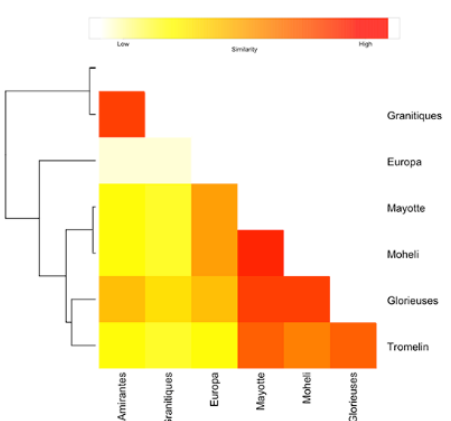
Figure 3. Schematic heatmap of pairwise similarity between drifting trajectories patterns of modeled particles from seven green turtle rookeries of the South West Indian Ocean. Light yellow / Intense red represents low / high similarity between drifting patterns. Drifting patterns similarities were computed as the opposite of the Euclidean distance between drifting density matrices.